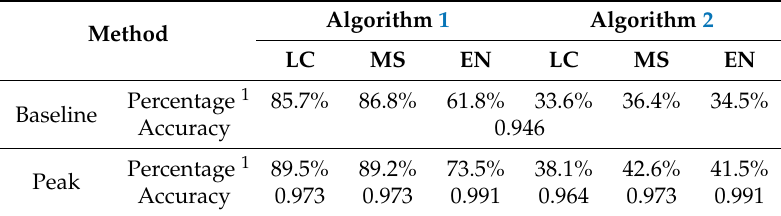
Table 1. Comparison of using three active learning criteria based on Algorithms 1 and 2, where LC, MS and EN represent least confidence, margin sampling and entropy, respectively. In baseline model, all the training set are manually